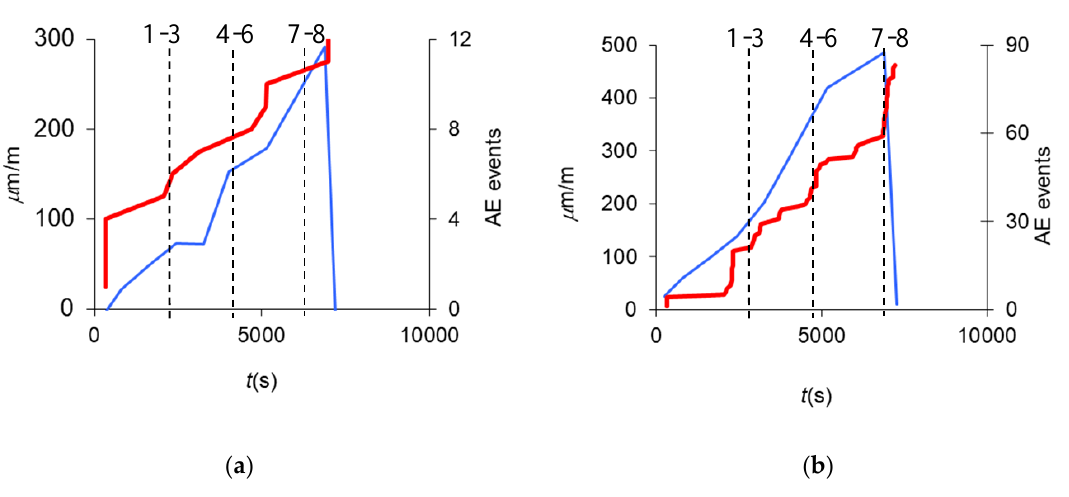
Figure 12. Cumulative AE activity (red) and FOS strain (blue) time histories for: ( a ) fiber optic n.9 at x = − 1.6 m and AE sensor n.4; ( b ) fiber optic n.9 at x = − 1.2 m and AE sensor n.5. The dashed lines identify the different loading stages.